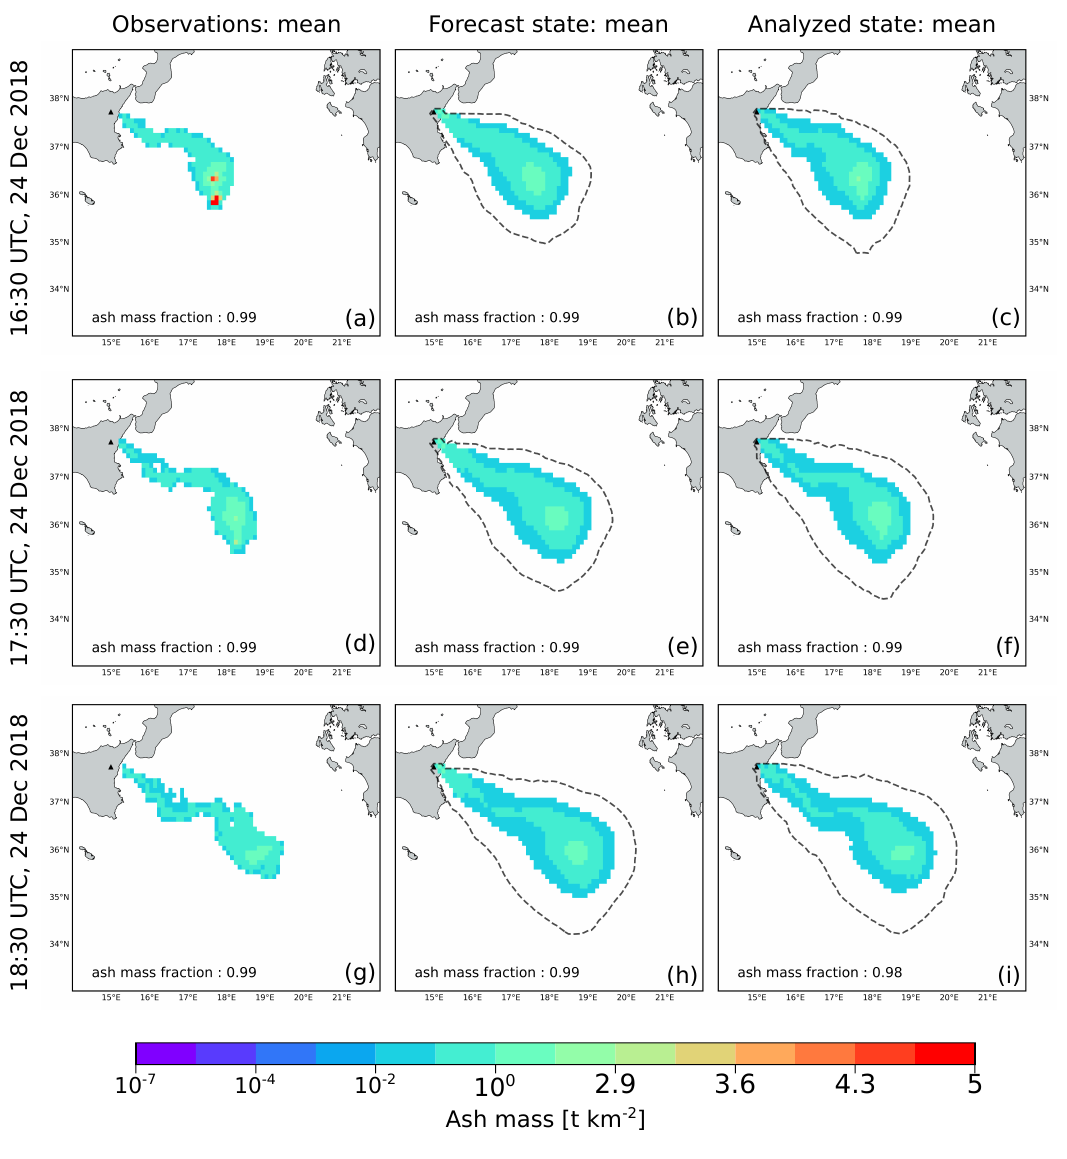
Figure 6. Mean states resulting from EXP1. Panels ( a , d , g ) show the ash cloud as detected from space (Observations). Panels ( b , e , h ) illustrate the ash cloud as predicted by the numerical model PLUME-MoM&HYSPLIT (Forecast state), while Panels ( c , f , i ) present the results of the assimilation cycles (Analyzed state). A cut-off of 0.01 t km − 2 was applied to original ash column density. The edges of the original ash cloud (both forecast and analyzed) are indicated by the black dotted lines. In this figure are displayed the assimilation cycles performed at 16:30, 17:30 and